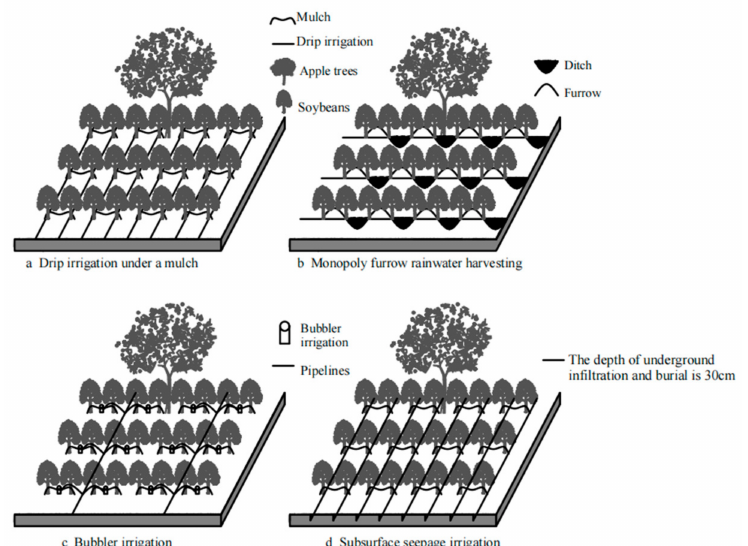
Figure 4. The layout plan for three different micro-irrigation